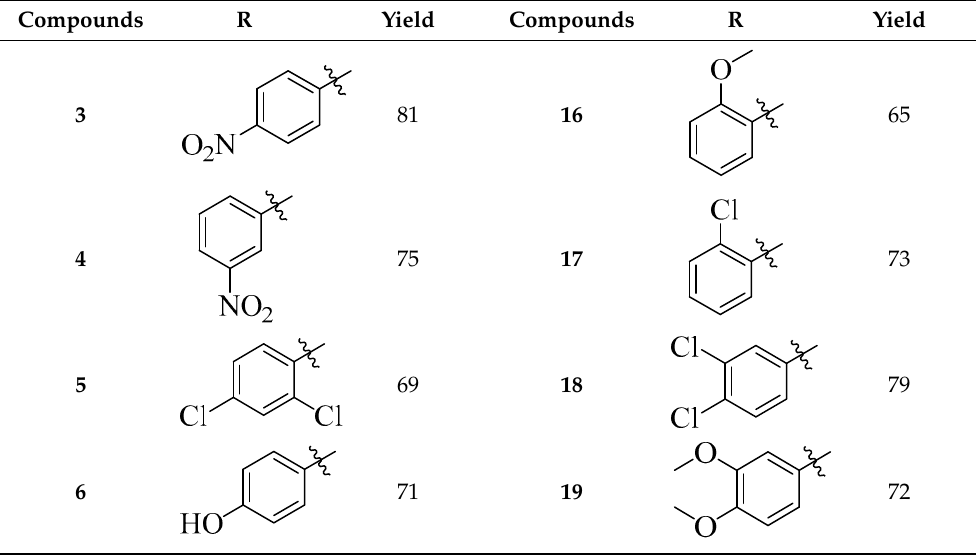
Table 1. Different aromatic/aliphatic (R) substituents of PHQ derivatives and their yields (%). Compounds